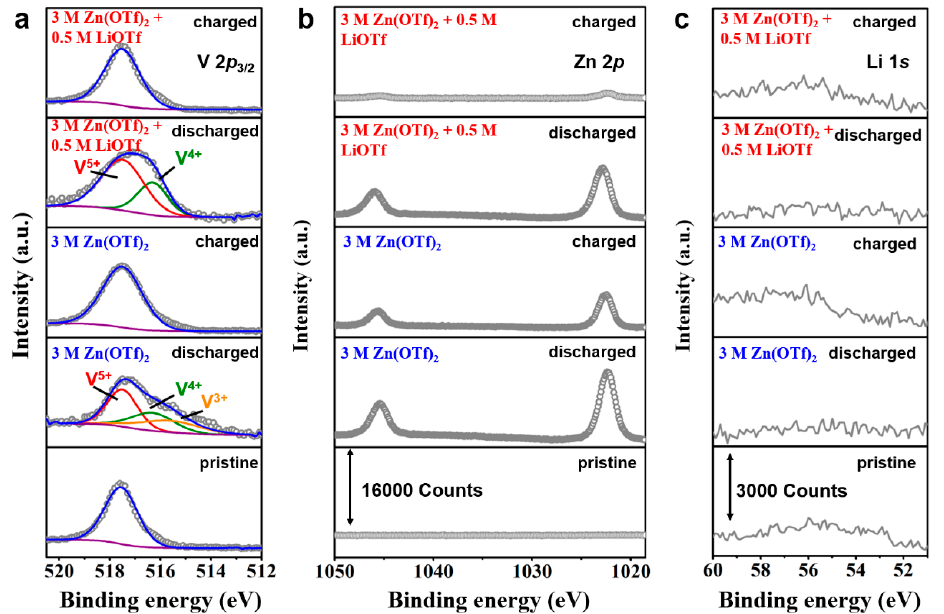
Figure 6. ( a ) V 2p, ( b ) Zn 2p, and ( c ) Li 1s XPS regions of the LV 3 O 8 electrodes in different electrolytes at different charge/discharge states.